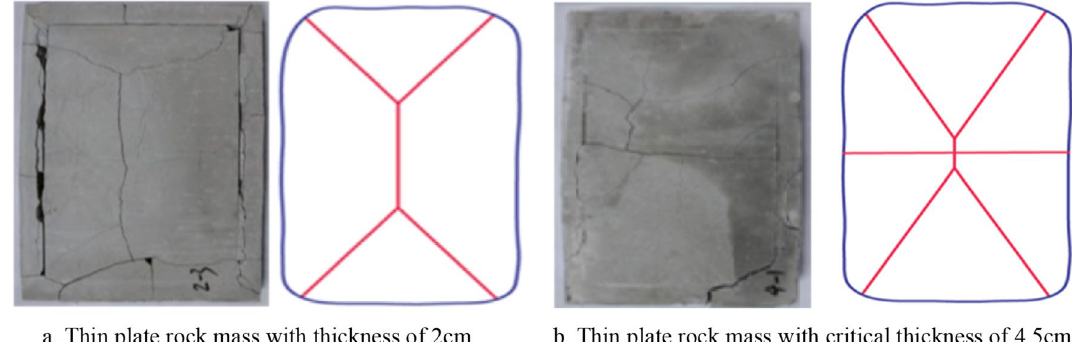
Figure 11. The failure pattern of single-layered thin plate rock mass under static